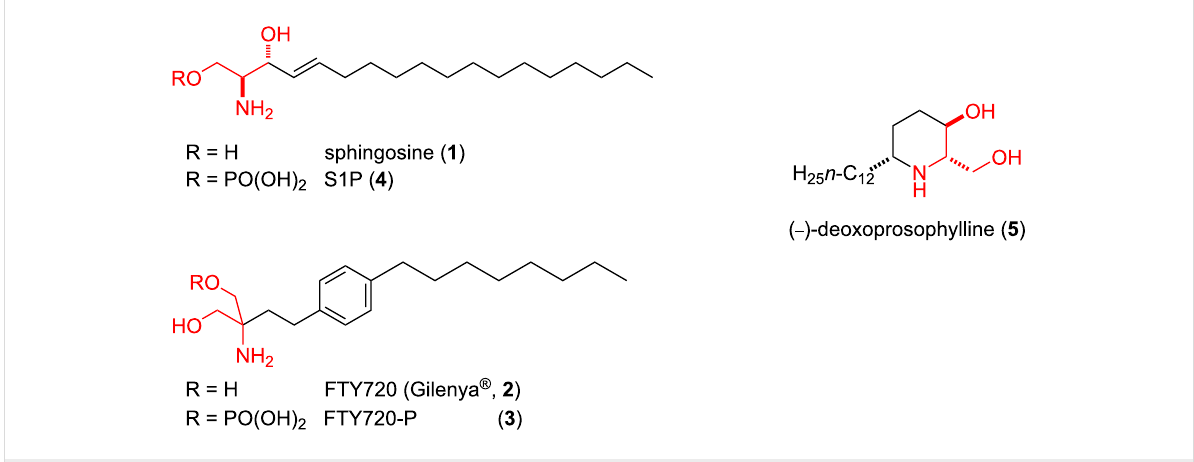
Figure 1: Biologically active